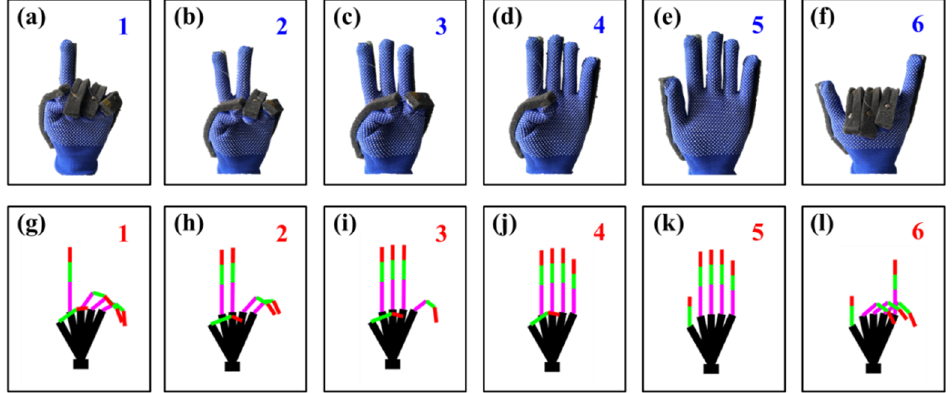
Figure 9. Verification of established finger bending model. ( a ) Hand gesture of 1. ( b ) Hand gesture of 2. ( c ) Hand gesture of 3. ( d ) Hand gesture of 4. ( e ) Hand gesture of 5. ( f ) Hand gesture of 6. ( g ) Model of hand gesture of 1. ( h ) Model of hand gesture of 2. ( i ) Model of hand gesture of 3. ( j ) Model of hand gesture of 4. ( k ) Model of hand gesture of 5. ( l ) Model of hand gesture of